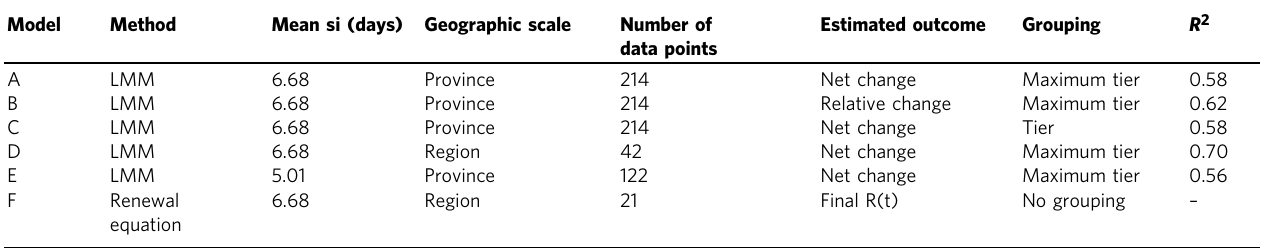
Table 3 Models to evaluate the change in transmissibility ( R ( t )) associated to